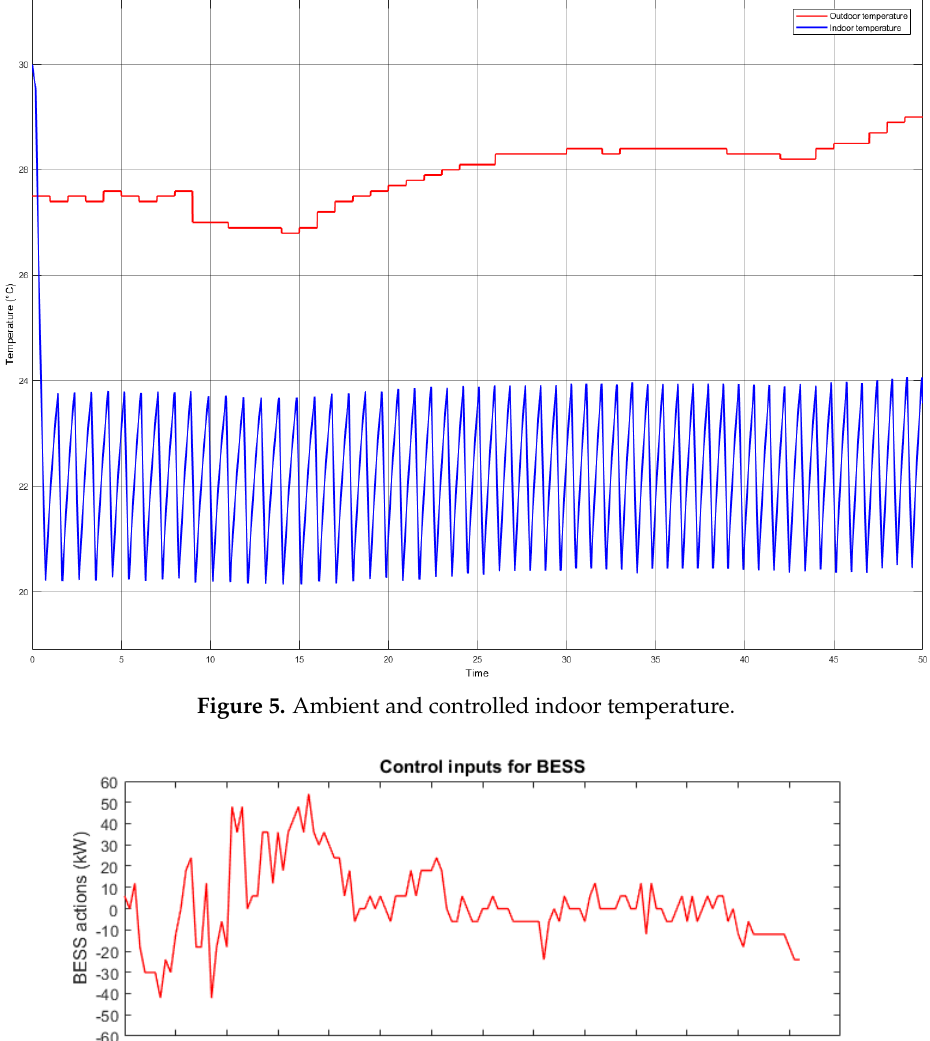
Figure 5. Ambient and controlled indoor temperature.